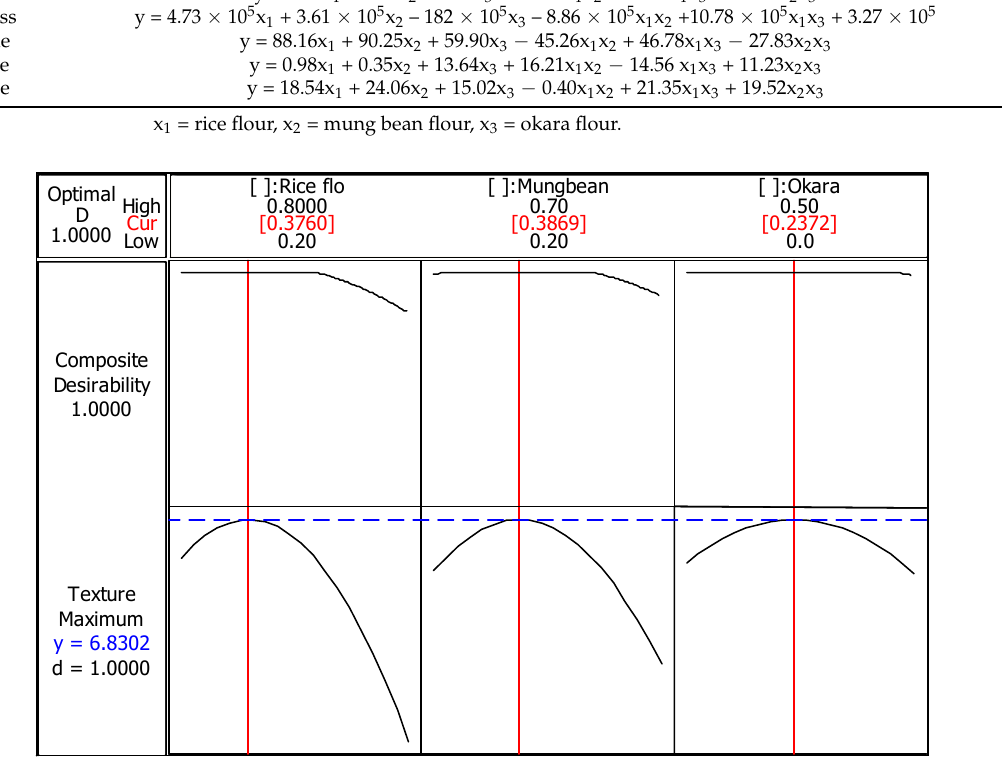
Figure 11. Optimal proportions of okara, mung bean, and rice flour for texture liking.